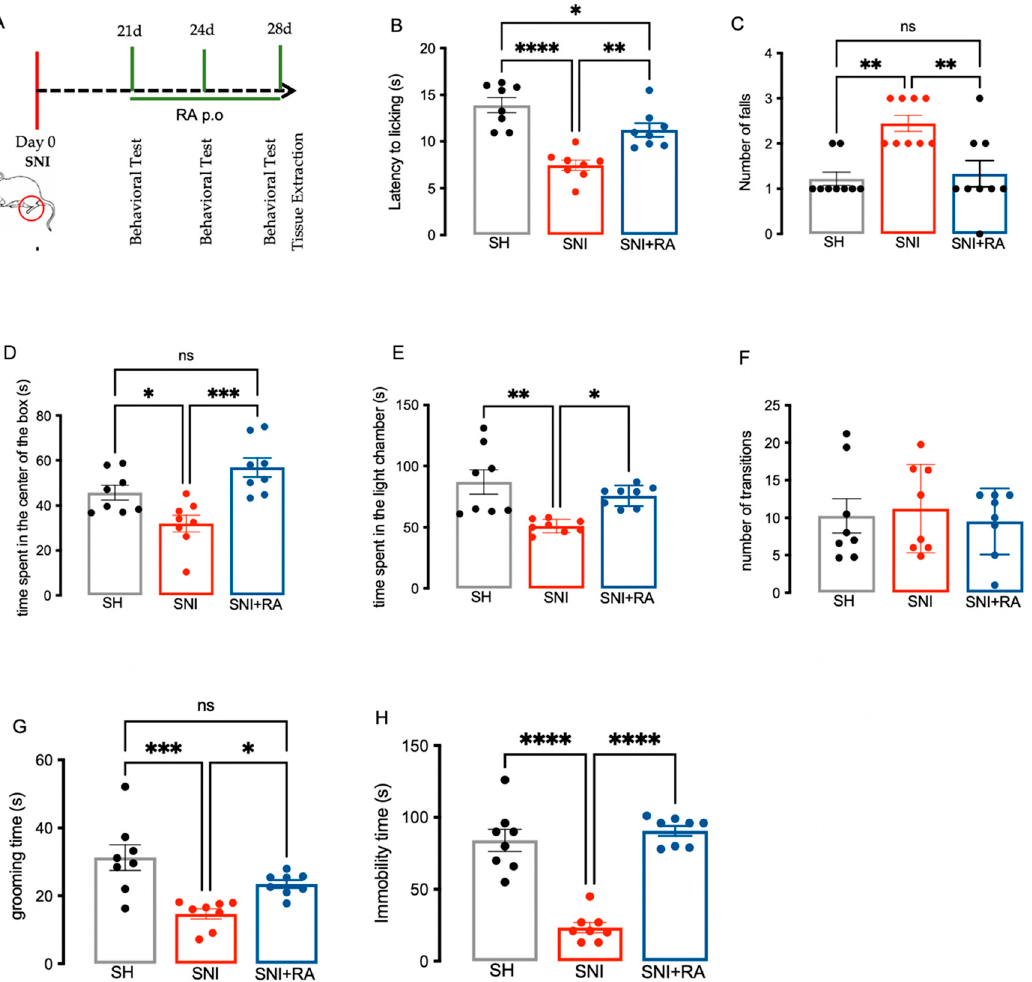
Figure 4. Effect of RA on SNI-induced behavioral phenotype. ( A ) Representation of the protocol used in the Spared Nerve Injury (SNI) model, in which the experimental group used are: unoperated mice (SH), operated mice (SNI), operated mice treated orally (p.o.) with rosmarinic acid (RA) 5 mg/kg ( n = 8 for each experimental group). Evaluation of thermal hyperalgesia with hot plate test ( B ), locomotor function with rotarod ( C ), anxiety-like symptoms with open field test ( D ), and light-dark box ( E ): time spent in the light chamber, ( F ): number of transitions), depressive-like symptoms with sucrose splash test ( G ), and tail suspension test ( H ), final 4 min) after three weeks from surgery in SH, SNI, and SNI + RA. Dots are number of animals. ns = not significant. One-way ANOVA **** p < 0.0001, *** p < 0.001, ** p < 0.01, * p < 0.05 .